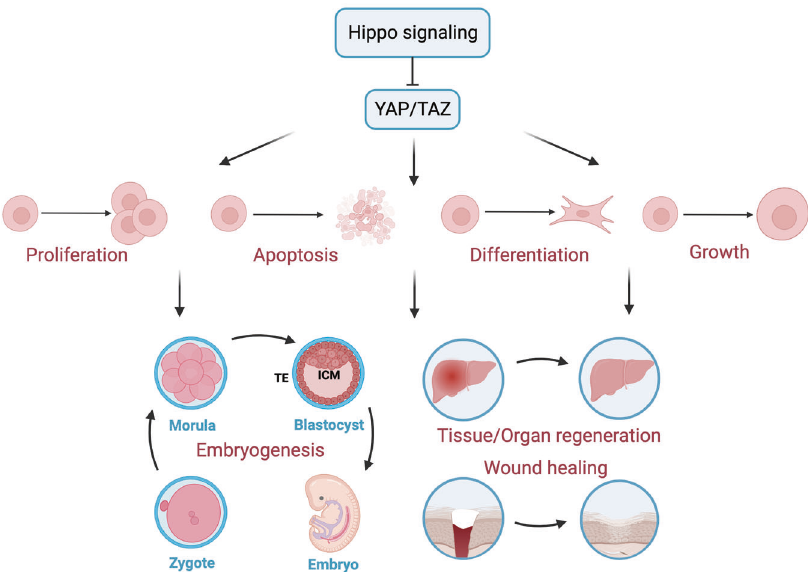
Fig. 4 The essential physiological function of Hippo pathway. The Hippo pathway effectors YAP/TAZ can take part in the modulation of multiple cell events, including proliferation, apoptosis, differentiation and growth, thereby participating in the physiological processes of embryogenesis and development, as well as tissue/organ regeneration and wound